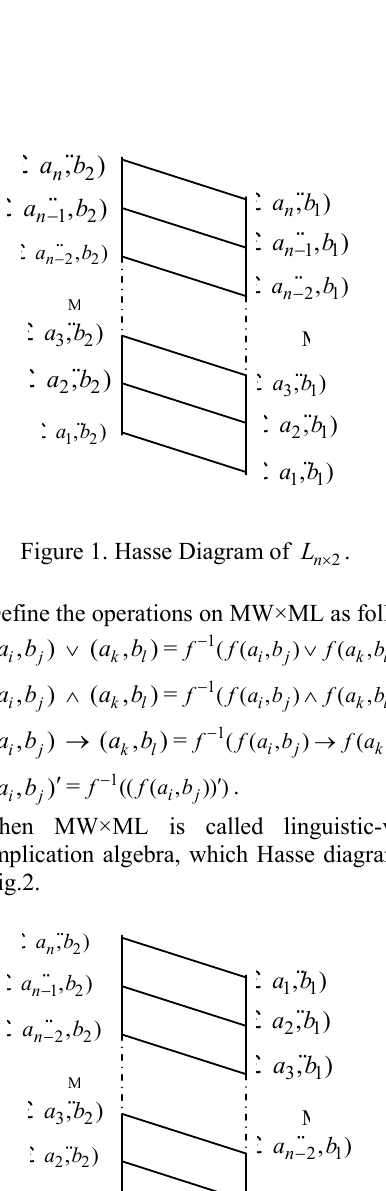
Figure 2. Hasse Diagram of